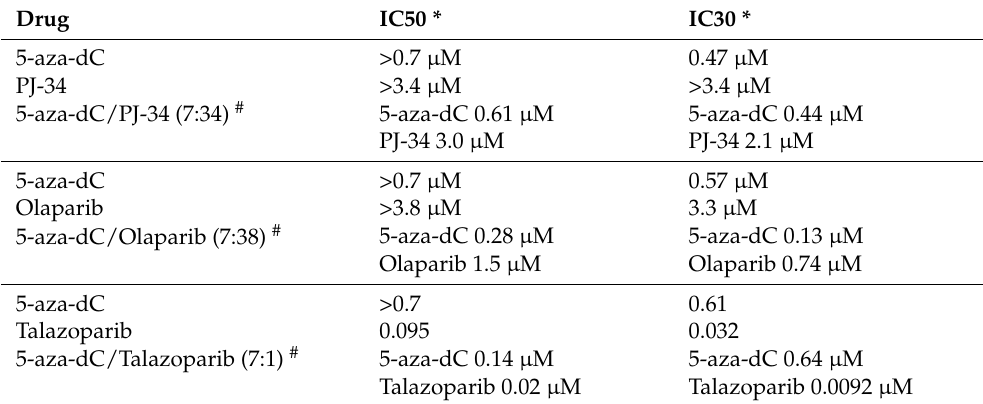
Table 1. The IC50 and IC30 values of 5-aza-dC, PARP inhibitors, and their combinations for HCT116